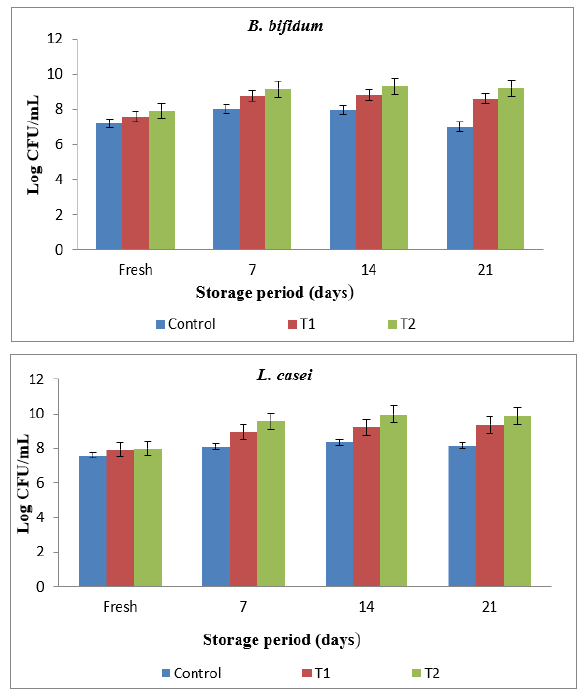
Determination of LD value of crude fucoxanthin 50 Figure 2: Counts of probiotic strains in stirred yoghurt treatments during storage. Control: plain yoghurt; T1: yoghurt containing 20 mg Corrected Probit Rat group Dose (mg/kg) Log dose Death crude fucoxanthin / kg milk; T2: yoghurt containing 30 mg death % crude fucoxanthin / kg milk. Data are expressed as a mean of three replicates ± SD.